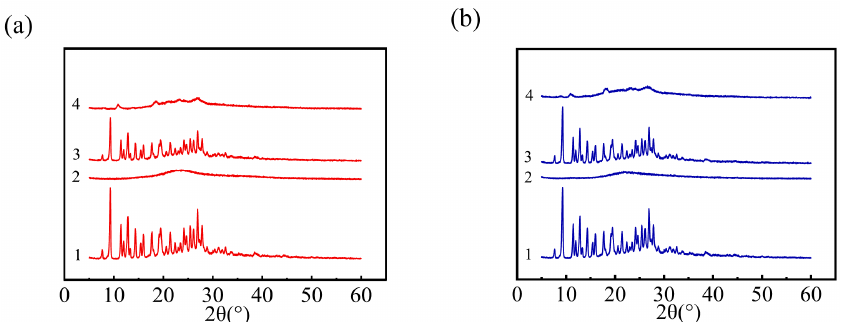
Figure 3. XRD patterns of PLL/MTX NPs (( a ), 1 MTX powder, 2 PLL, 3 the physical mixture of MTX and PLL, 4 PLL/MTX NPs) and PEG-PLL/MTX NPs (( b ), 1 MTX powder, 2 PEG-PLL, 3 the physical mixture of MTX and PEG-PLL, 4 PEG-PLL/MTX NPs).